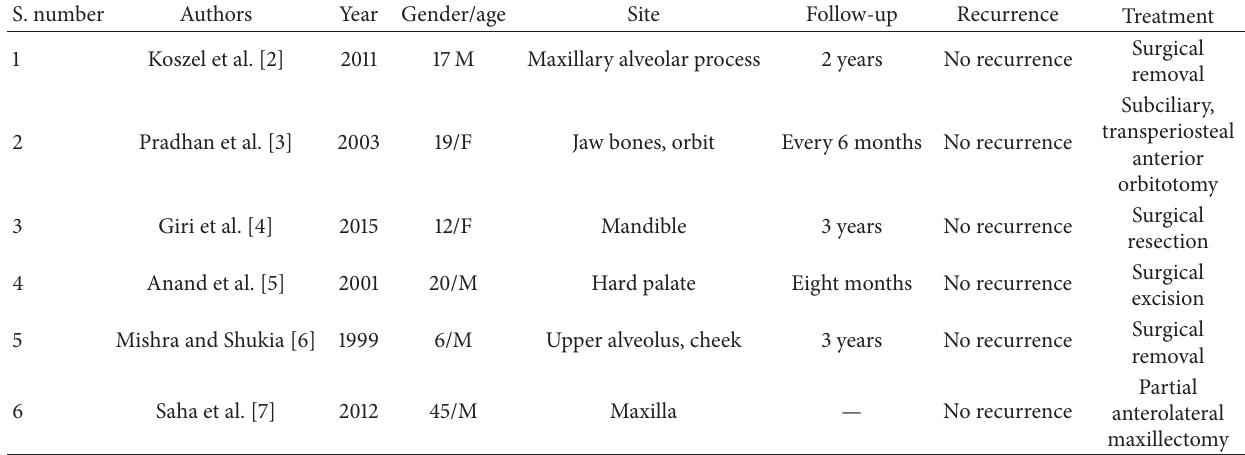
Table 1: Literature review of previously reported cases of oral cavity with treatment